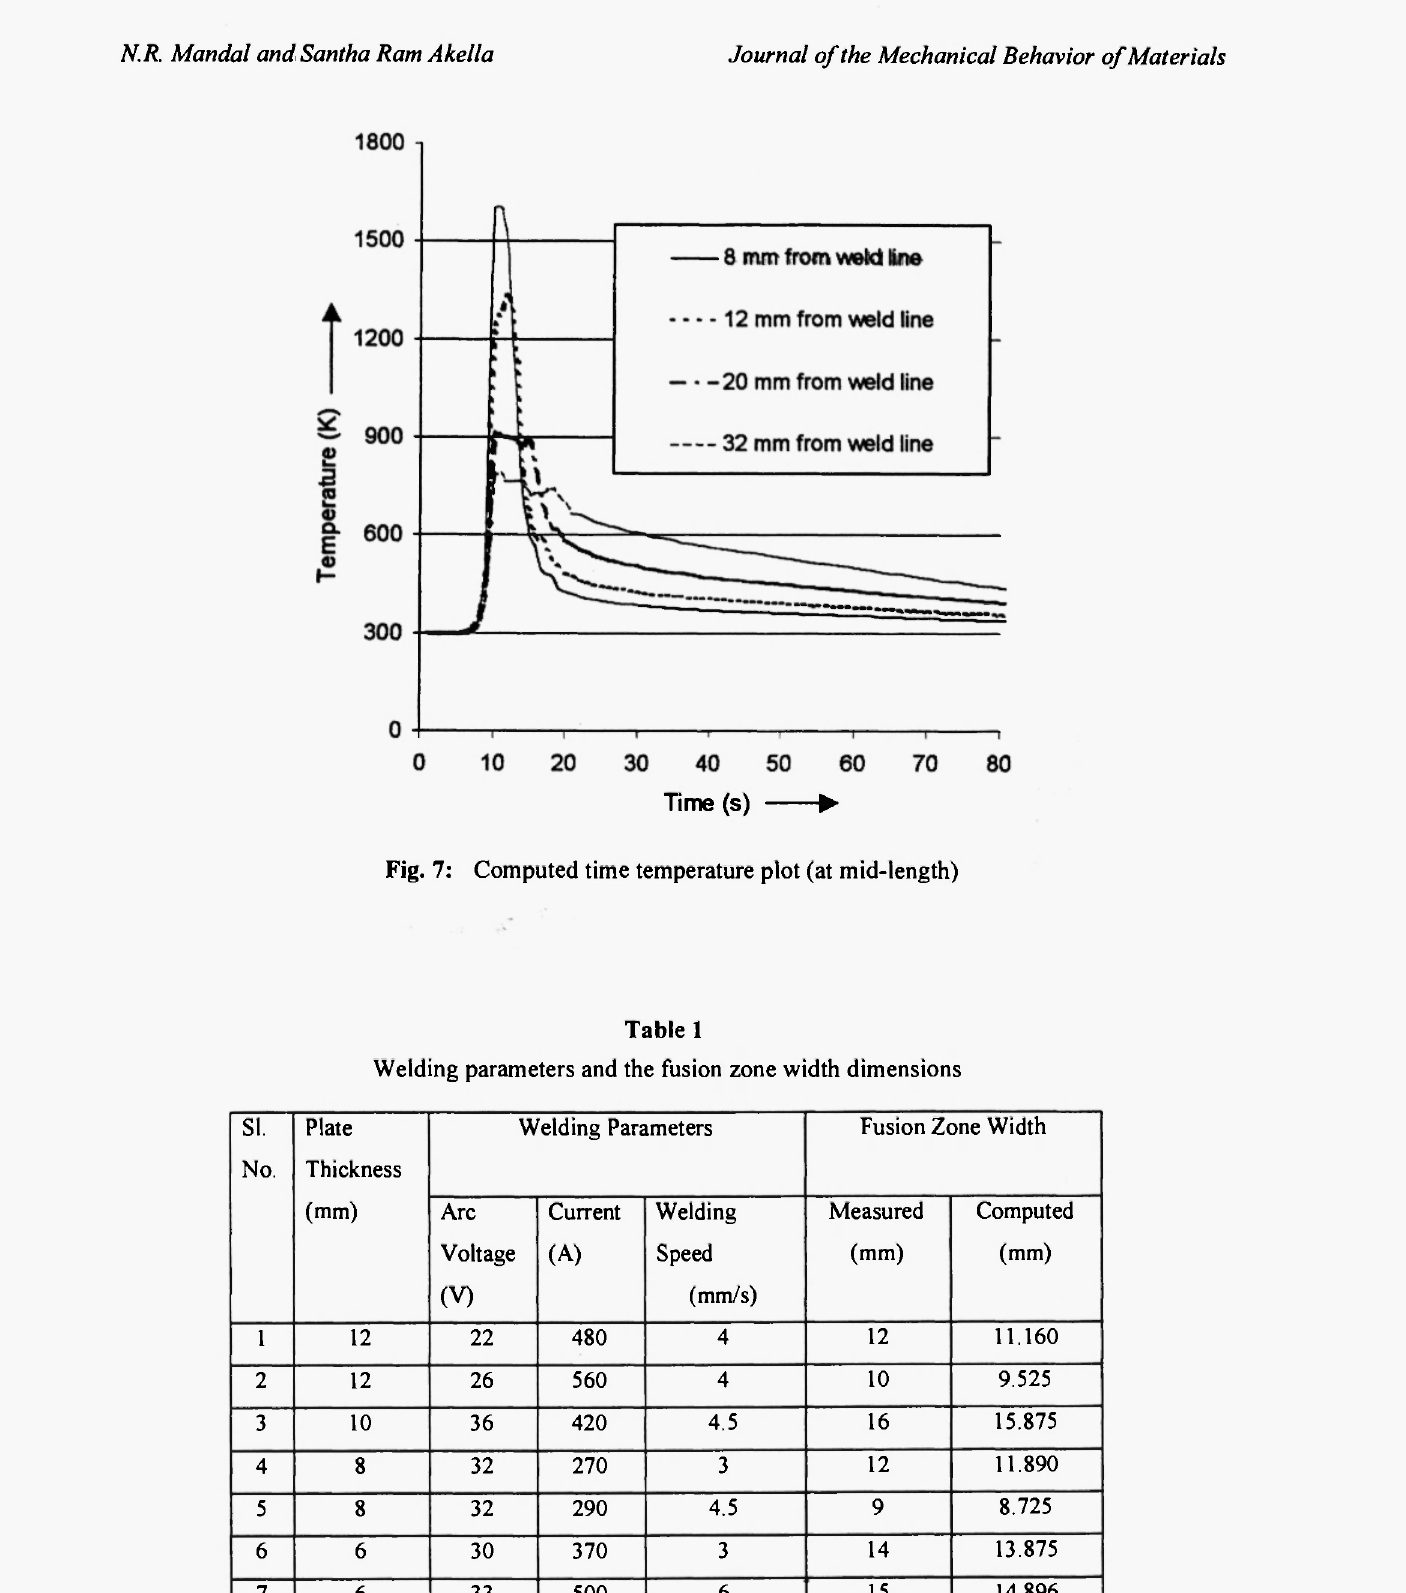
Welding parameters and the fusion zone width